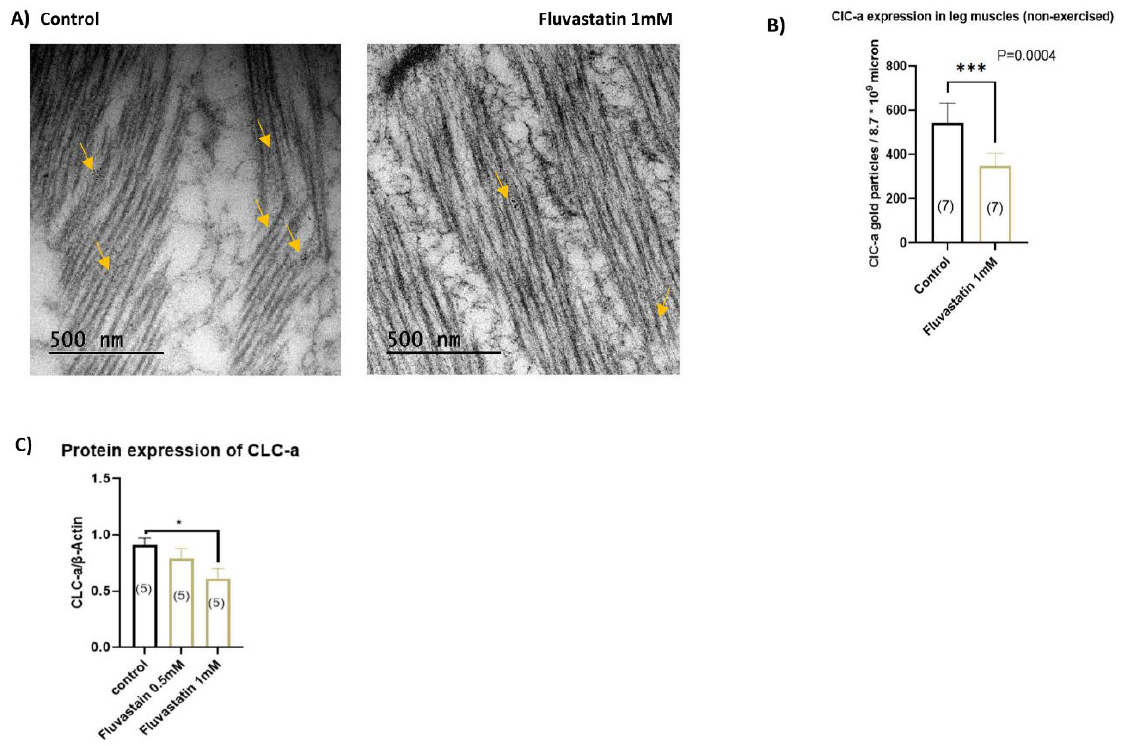
Figure 5. Fluvastatin significantly lowered the expression of the ClC-a channels in the leg’s skeletal muscles of CSORC flies. ( A ) TEM micrographs of double labelling using CLC-2 (rabbit anti-ClC-2 antibody) show immunogold particles of ClC-a (yellow arrow) in the femur segment of the legs of CSOCR flies. The morphology of the muscles is poor due to the treatment necessary for im- munolocalization. The skeletal chloride channel, ClC-a, is localized along the T-tubules. ( B ) The histogram represents the quantification of ClC-a gold particles in dissected skeletal muscles of femur and tibia segments of CSORC fly legs using ImageJ software. The Shapiro–Wilk test was used to check normality and accordingly, Student’s t -tests were used to calculate the significant difference between groups. The number of TEM grids in each group is indicated in brackets. ( C ) The histogram represents the quantification of the protein relative levels of ClC-a whereby the relative protein intensity was calculated by normalising the absolute intensity of ClC-a protein with β -Actin. The whole body of 10 flies were used per sample and the number of replicates is indicated with the brackets. The Shapiro–Wilk test was used to check normality and accordingly, one-way ANOVA with Bonferroni’s multiple comparisons test was used to calculate statistical significance whereby * p ≤ 0.01; *** p ≤ 0.005. Each bar represents the mean value ( ±